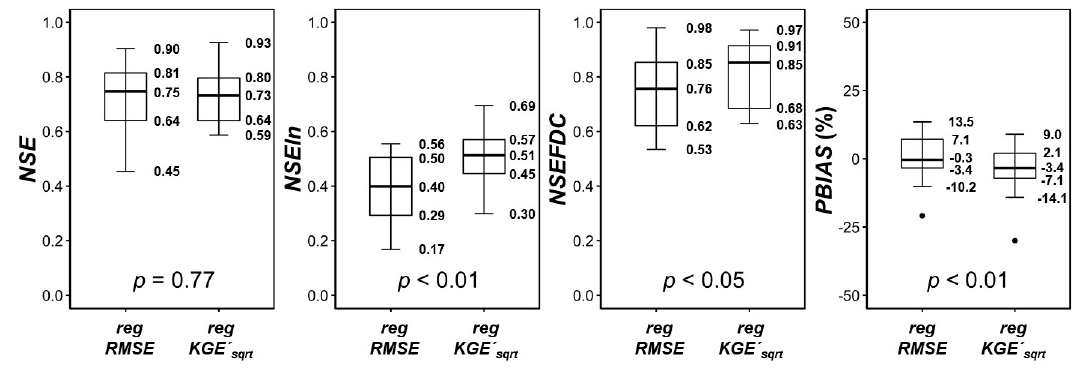
Figure 7. Comparison of performance statistics ( NSE , NSEln , NSEFDC , and PBIAS ) provided by the two regression models ( regRMSE and regKGE (cid:48) sqrt ) for the 10 validation watersheds.